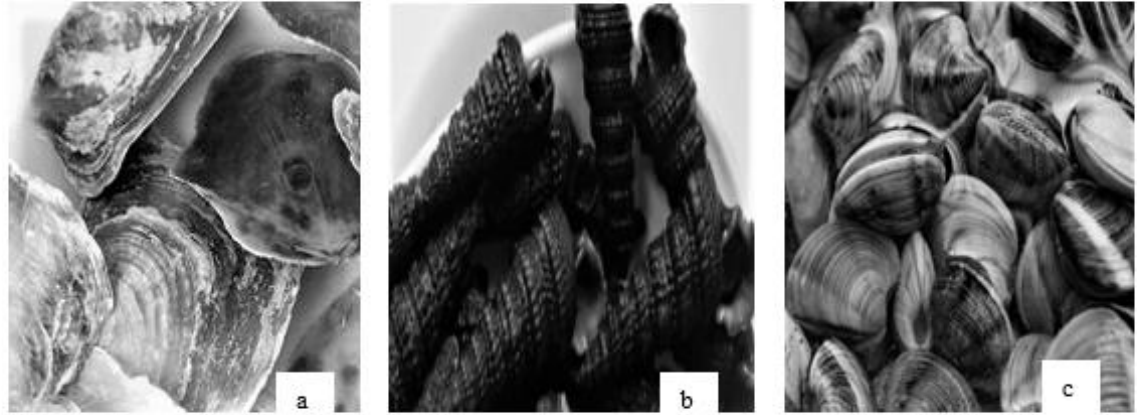
Figure 1. As-collected shells of Clam (a), Periwinkle (b) and Oyster